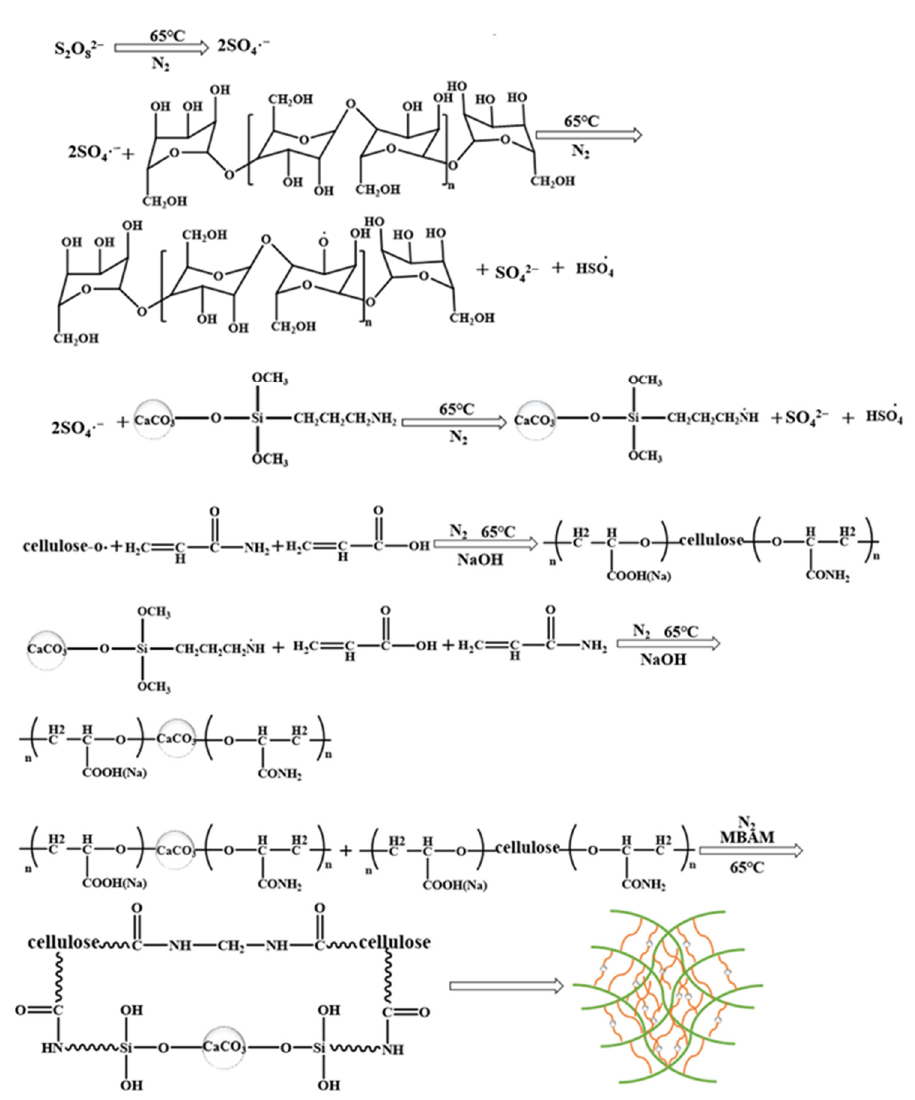
Figure 7. The suggested grafting mechanism for MNC, AA, AM, and BC.